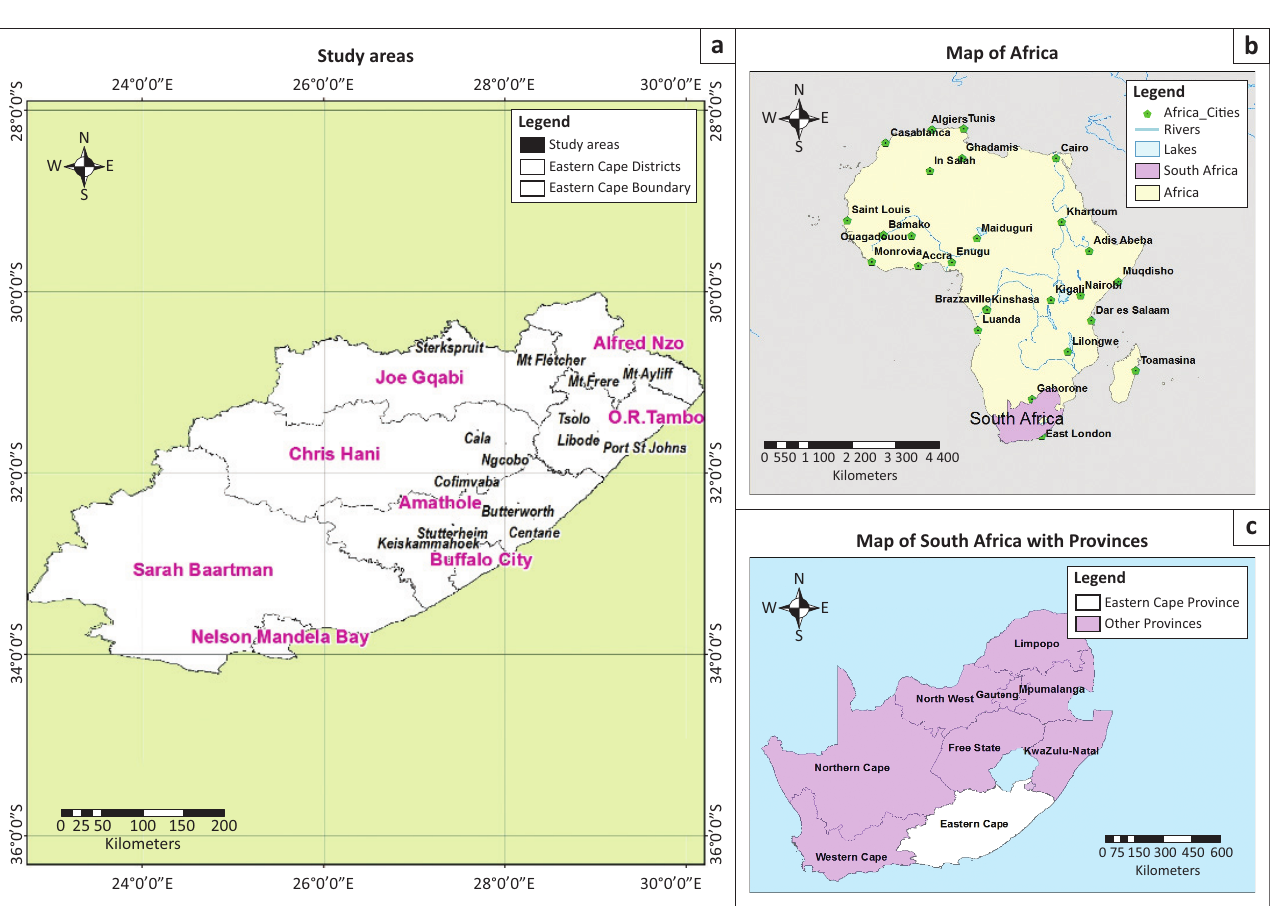
Source: Eastern Cape Department of Rural Development and Agrarian Reform GIS Unit FIGURE 1: Geographical map of the study